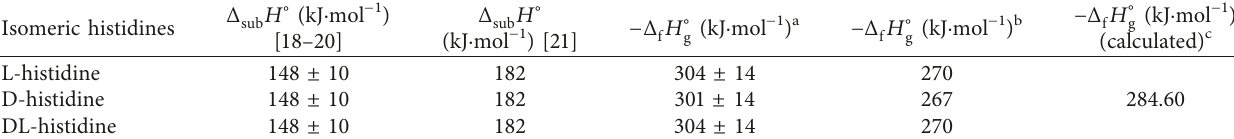
Table 6: Ideal gas state enthalpies of formation of isomeric